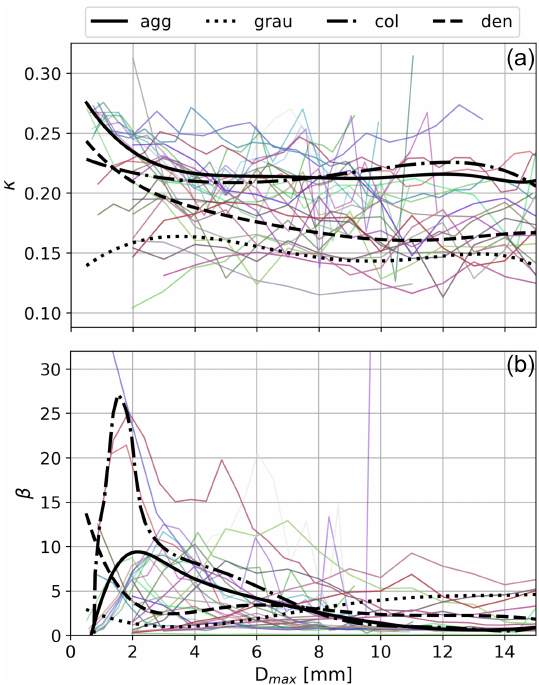
Figure B5. Colored lines: coefficient of the SSRGA computed in Ori et al. (2020) for a given particle type (as a function of D max ) for (a) κ SSRG and (b) β SSRG . Black lines: average coefficient when grouping by particle type, used for sampling the training